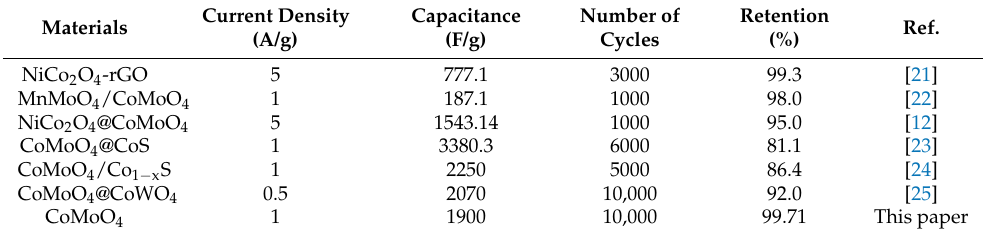
Figure 3. ( a ) CV curves of CoMoO 4 nanoparticles at different scan rates. ( b ) Charge – discharge Figure 3. ( a ) TEM image of the hybrid CoMoO 4 pie nanoparticles. ( b ) HRTEM image of the as- curves of CoMoO 4 nanoparticles at different current densities. ( c ) Specific capacitance of CoMoO 4 prepared CoMoO 4 nanoparticles and the inset is the corresponding SAED pattern. ( c ) The EDS nanoparticles at varied current densities. ( d ) The cycling performance of pie-shaped CoMoO 4 at the spectrum of CoMoO 4 nanoparticles. ( d ) XRD pattern of CoMoO 4 nanoparticles. ( e ) Nitrogen current density of 15 A/g. ( e ) Nyquist plot of CoMoO 4 nanoparticles. ( f ) Rate and cycle stability tests adsorption–desorption isothermal curve. under different current densities. Table 1. Comparison of properties of electrode materials with Table 1. Comparison of properties of electrode materials with references.